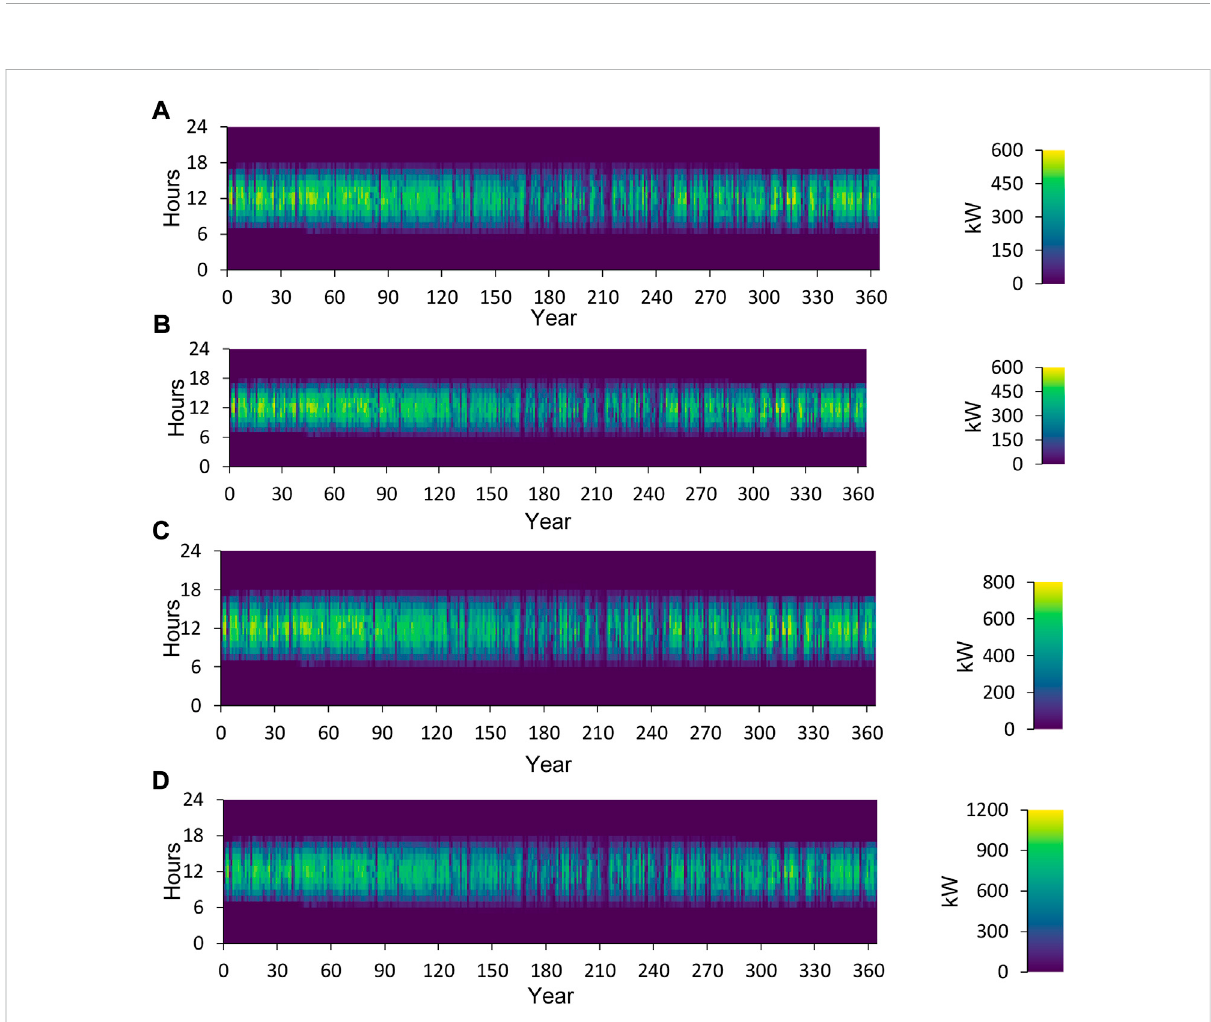
FIGURE 5 Power output from the solar photovoltaic plant as per the scaled average daily sessions. (A) 10, (B) 20, (C) 30, and (D)